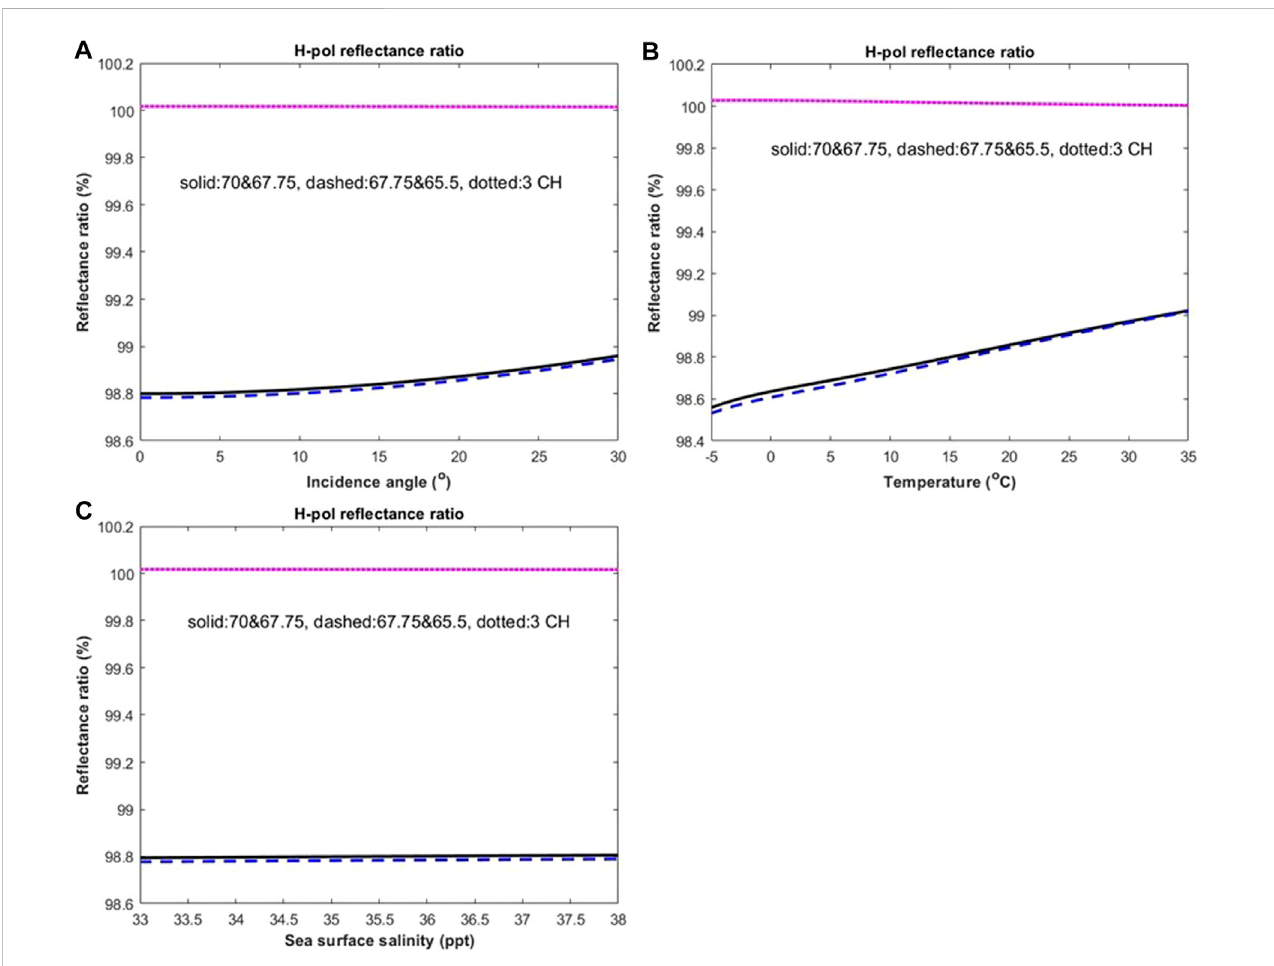
FIGURE 2 Similar as Figure 1, except for sea surface re fl ectance ratios of neighboring 70.0 and 67.75 GHz (black solid curve) and 67.75 and 65.5 GHz (blue dashed curve)pairs.Parts (A-C) areforincidenceangle,seasurfacetemperature,andseasurfacesalinity,respectively.Themagentadottedcurveisfortheratiosofthe tworatiosofpairedfrequenciesorthethree-channelapproach.Additionalbasicenvironmentalconditionassumedis7 m/sand0 ° azimuthangledirectionfor sea surface